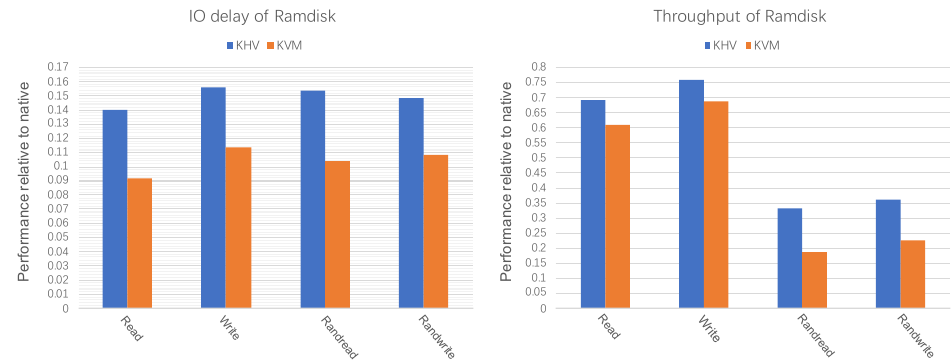
Figure 17. IO delay and throughput of